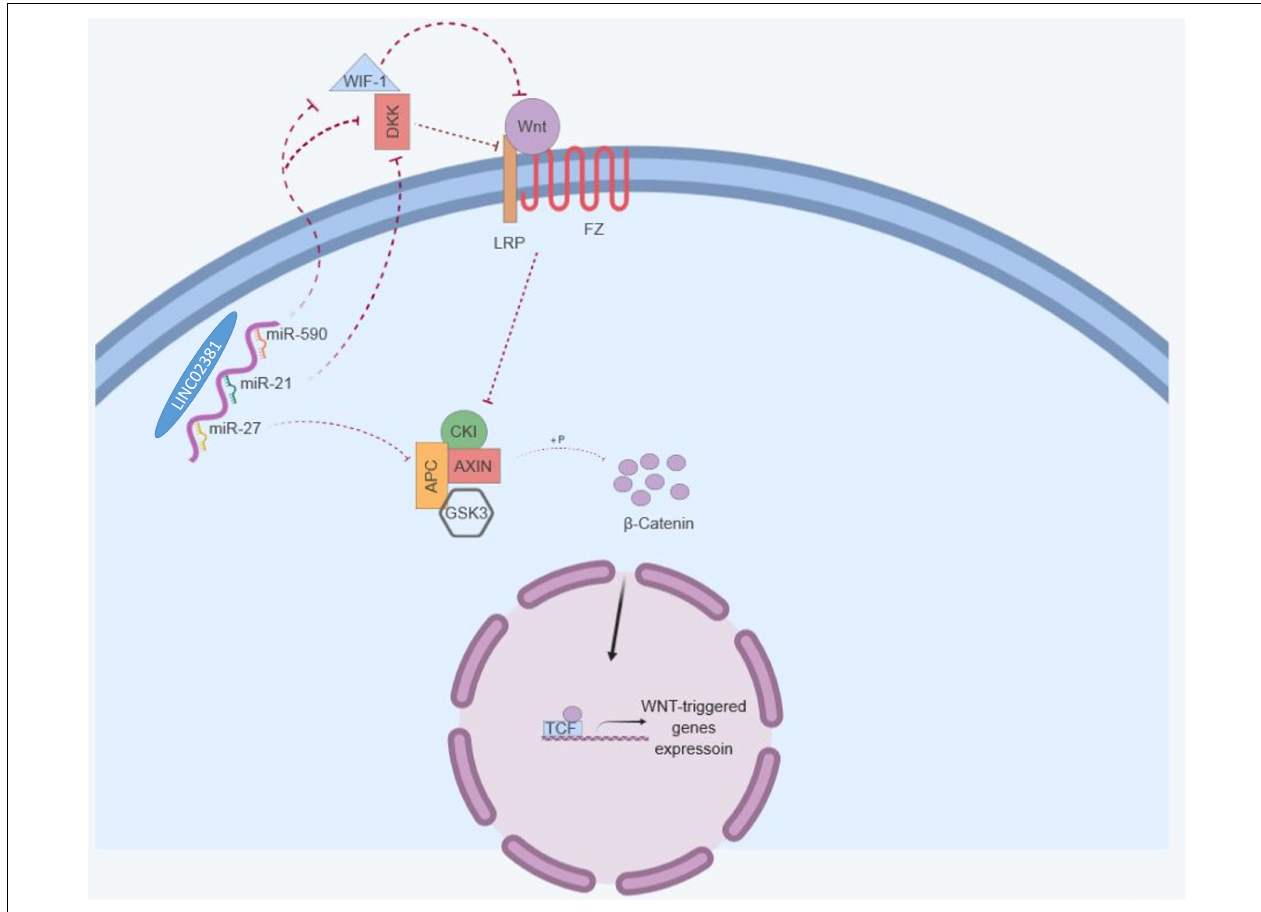
FIGURE 7 | Schematic representation of LINC02381 effect on Wnt signaling pathway. LINC02381 functions as a competitive endogenous RNA (CeRNA) by sponging miR-21, miR-590, and miR-27a. LINC02381 and Wnt inhibitor genes are targets of miR-21, miR-590, and miR-27a. These miRNAs, by inhibiting expression of Wnt inhibitors, enhance the activation of Wnt signaling. LINC02381 competitively binds these miRNAs, resulting in increased expression of target genes (Wnt inhibitors) that prevents Wnt activation.